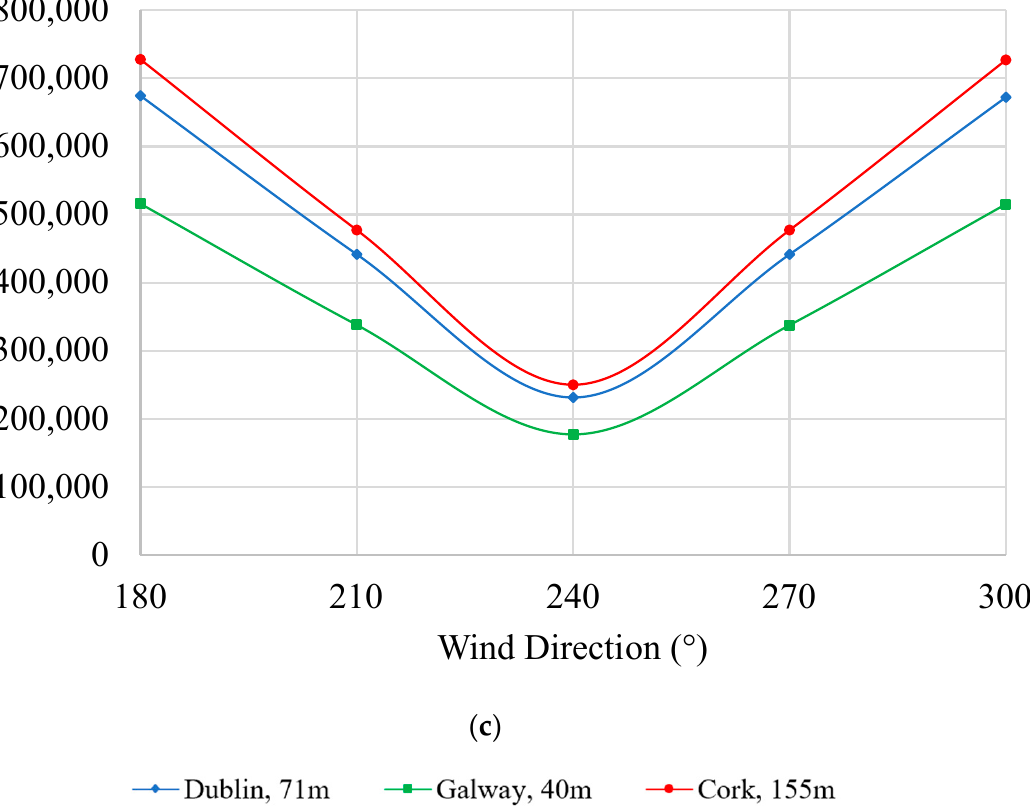
Figure 4. Wind force plotted against wind direction for ( a ) Deck in the x-direction; Wind force acting on the deck in the x-direction; ( b ) Deck in the z-direction; Wind force acting on the deck in the z-direction; ( c ) Piers in the x-direction; Wind force acting on the piers in the x-direction.